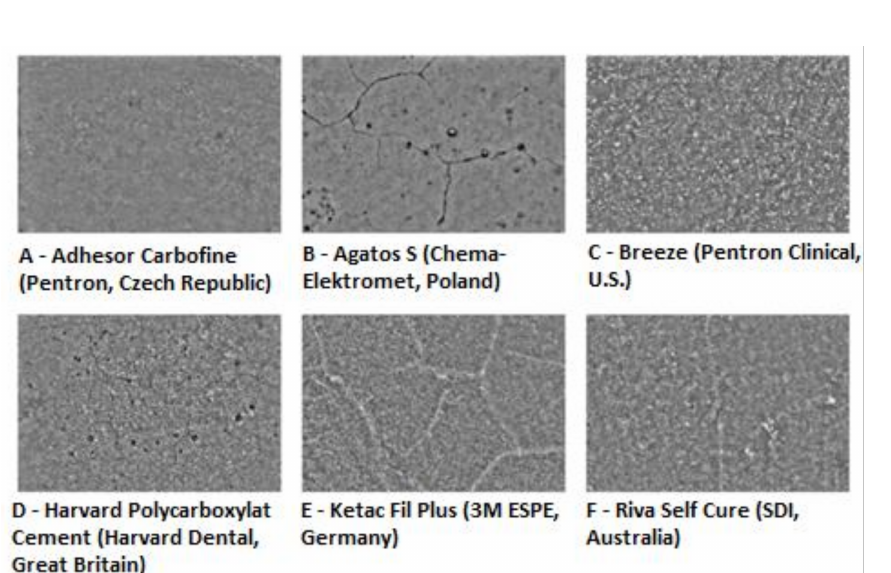
Figure 5. Examples of light microscope images of the surface of the tested cements subjected to subsequent analysis of textures and the fractal dimension (magnified 18